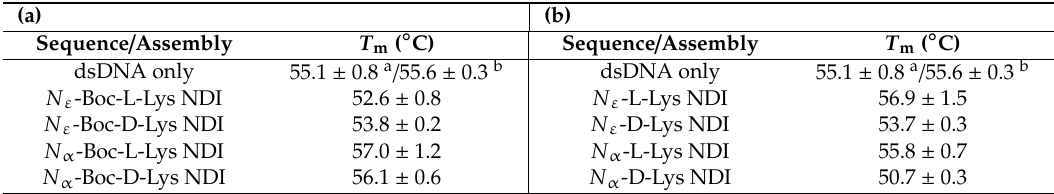
Table 6. The T m values of dsDNA only compared to the T m of ( a ) dsDNA-Boc-protected-NDIs and ( b ) dsDNA-deprotected-NDIs as determined from VT CD